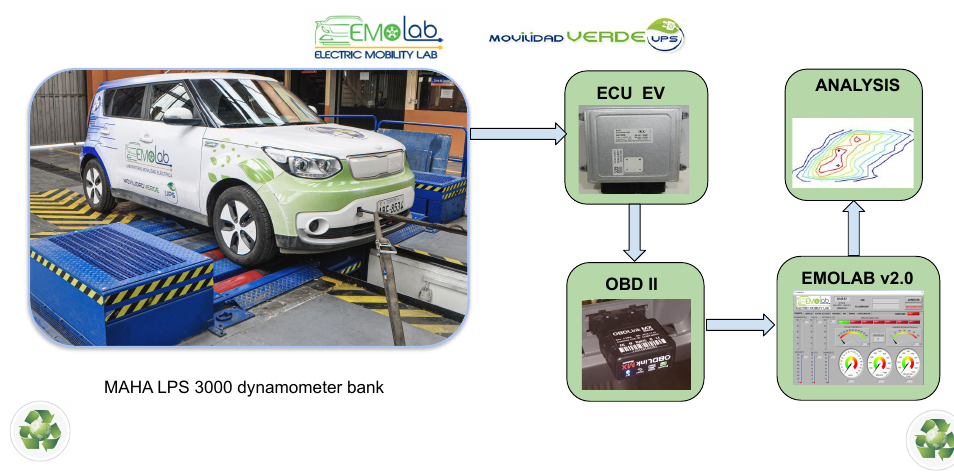
Figure 5. Inverter and motor efficiency experiment setup on the dynamometer bank. After analyzing data from experiments, the inverter efficiency curve as a function of the motor’s rotational speed is shown in Figure 6. The inverter in this study shows minimum efficiency of 94% at high speed and maximum efficiency of 99% at low speed.